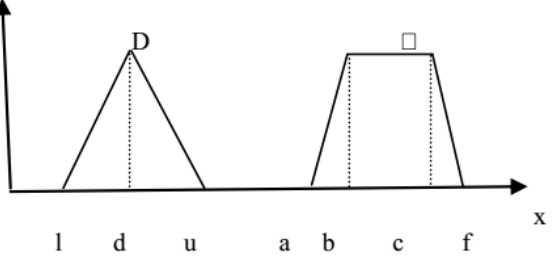
Fig. 1. Triangular and trapezoidal fuzzy